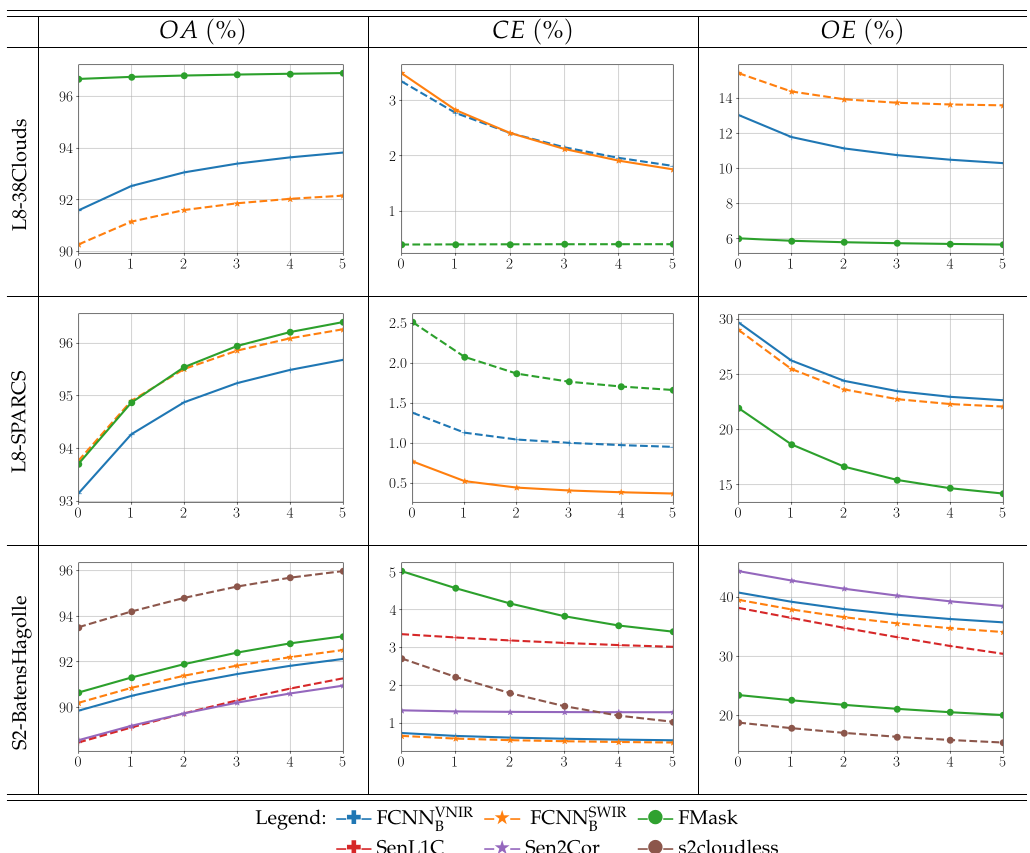
Figure 7. Evaluation of the models comparing performance metrics ( y -axis) with respect to the w values ( x -axis) in the cloud masks. Each row corresponds to a different evaluation dataset, and each column represents a different performance metric in percentage: overall accuracy, commission error, and omission error,